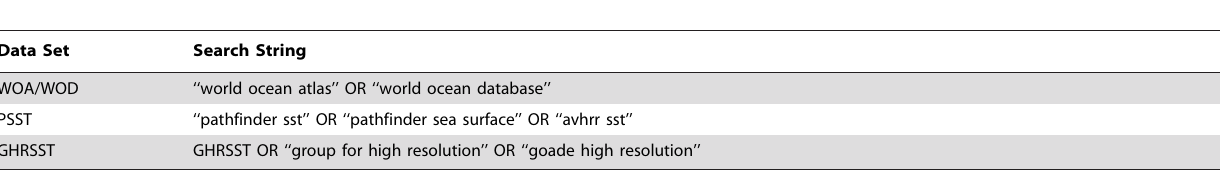
Table 1. Search strings used to generate citation counts for three data sets in WoS, publishers’ full text websites, and Google